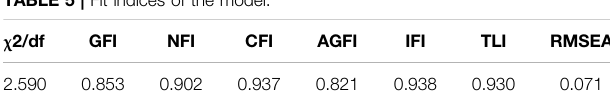
TABLE 5 | Fit indices of the model.